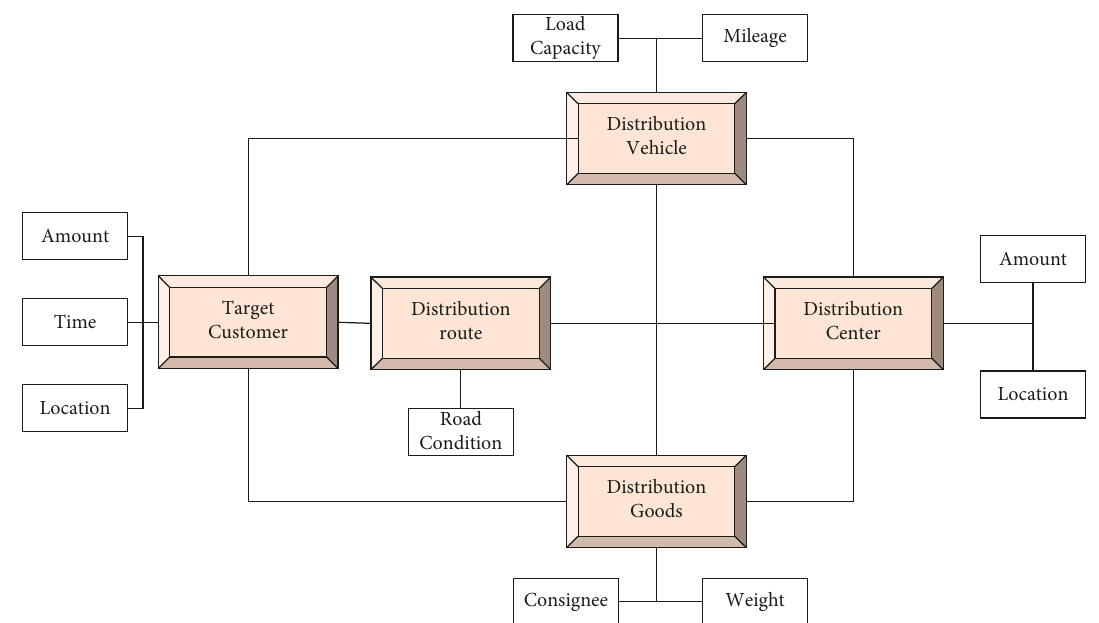
Figure 4: Interrelationship of the factors affecting logistic distribution.